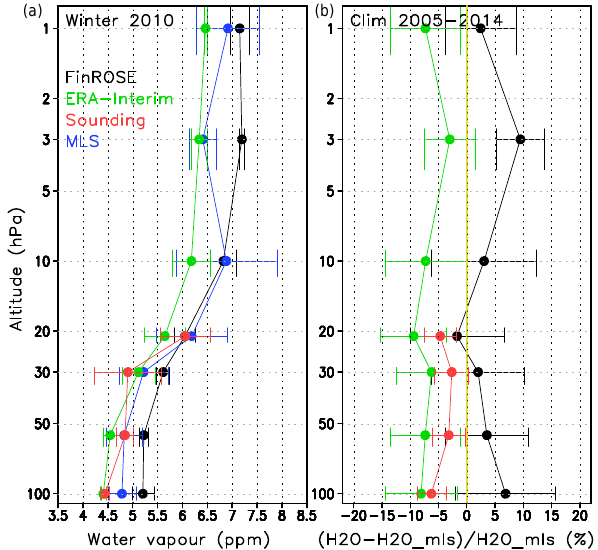
Figure 2. Panel (a) : 2010 mean January and February water vapour mixing ratio and standard deviation above Sodankylä as a function of pressure. Panel (b) : difference of the modelled or observed winter water vapour mixing ratio and the MLS calculated over the years 2005 to 2014 above Sodankylä as a function of pressure. FinROSE (black), MLS (blue), ECMWF ERA-Interim (green), and soundings (red).